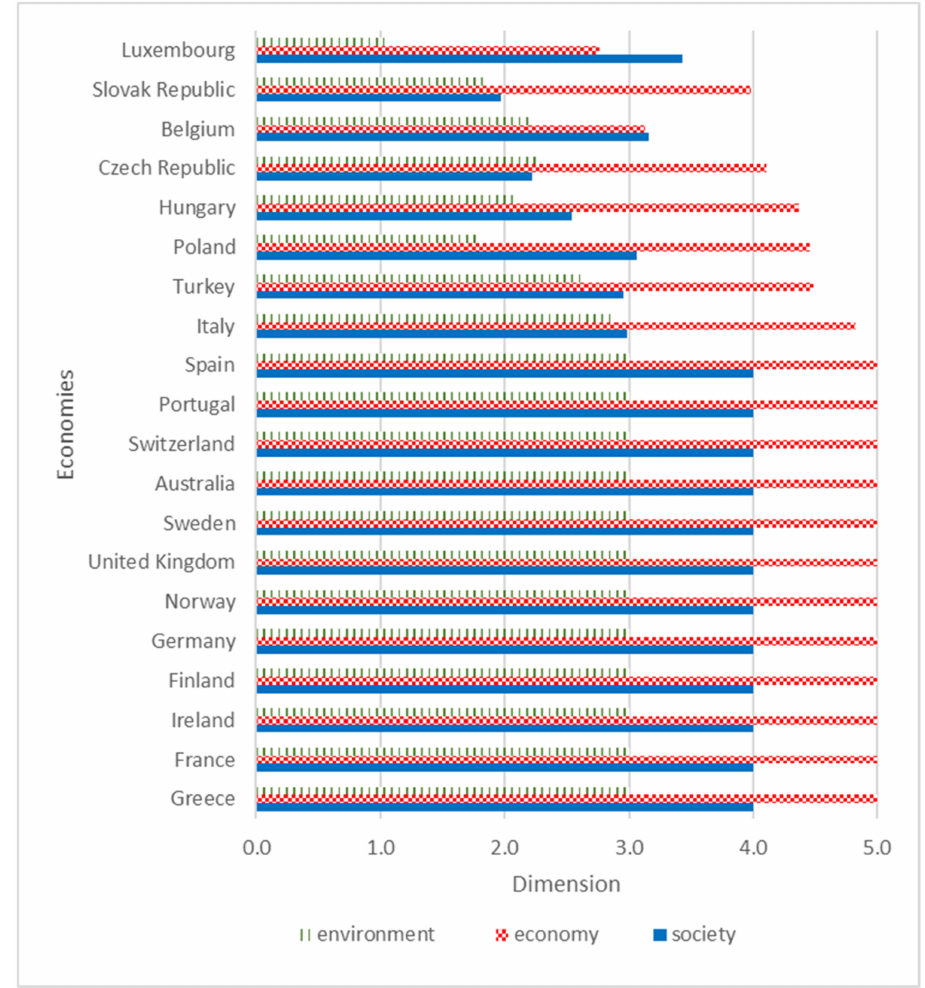
Figure 2. Sub-dimensional energy resilience of European